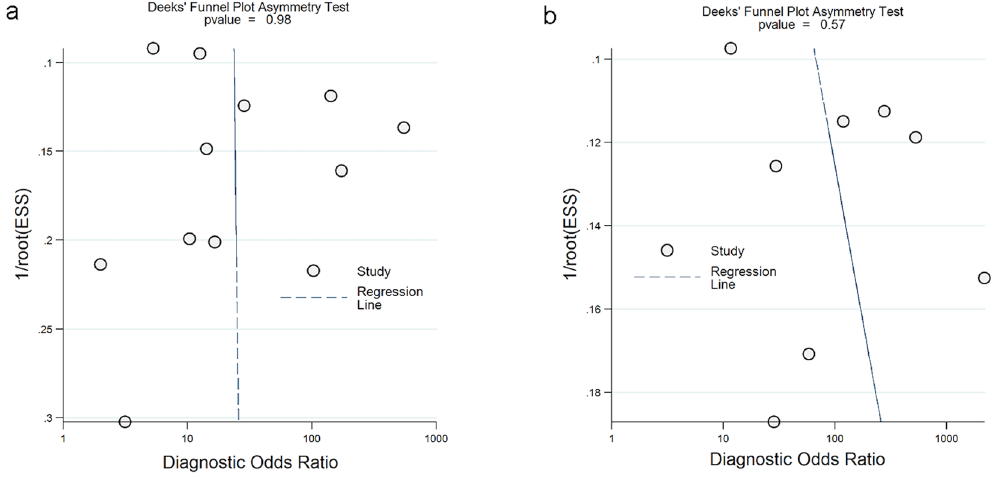
Figure 4. Funnel plots for the included studies: serum IL-6 ( a ) and synovial fluid IL-6 ( b